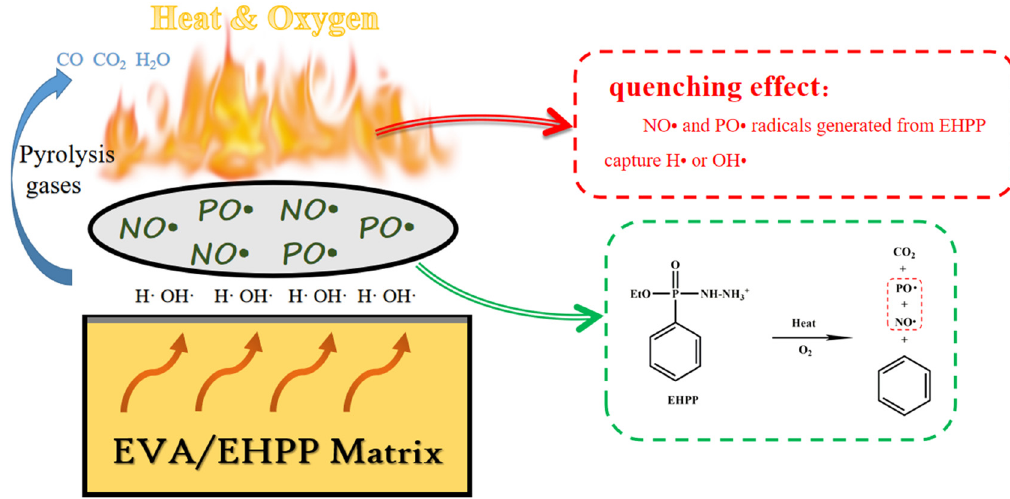
Figure 8: Hypothetical fl ame retardant mechanism of EVA and its